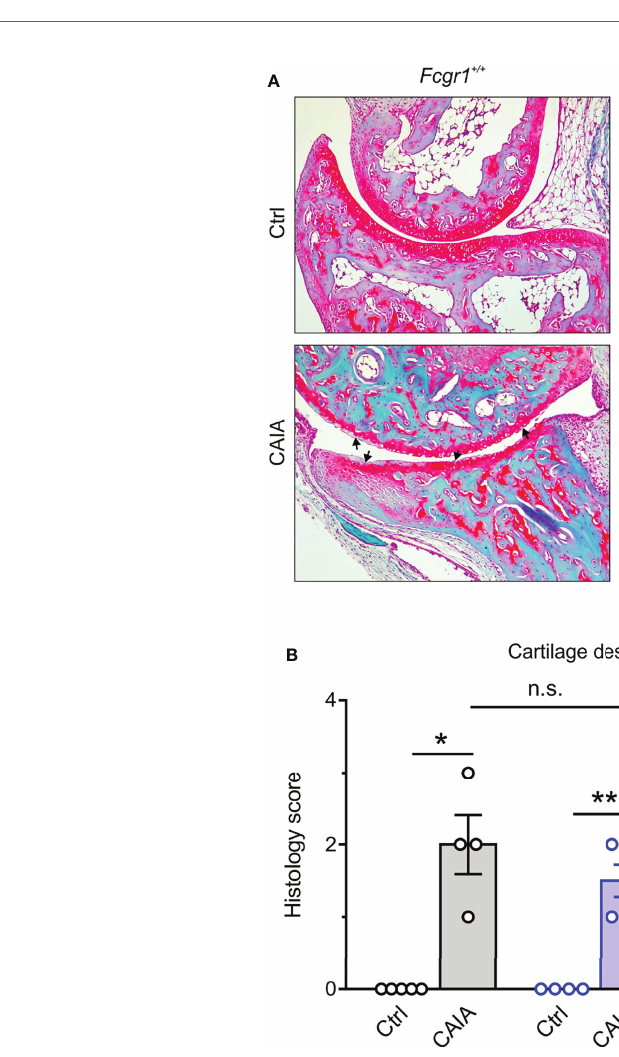
FIGURE 2 | Fc g RI is not necessary for cartilage destruction in the postin fl ammatory phase of CAIA. (A) Representative images of Safranin O/fast green-stained ankle joints from Fcgr1 +/+ and Fcgr1 -/- mice on day 56 after CAIA. Arrowheads indicated cartilage destruction. Scale bar, 200 m m. (B) No obvious differences in the histology score for cartilage destruction were observed at day 56 after CAIA between genotypes. n = 4 - 6 mice/group; *p < 0.05; **p < 0.01 versus control (Ctrl), two-way ANOVA followed by Bonferroni correction. n.s., not signi fi